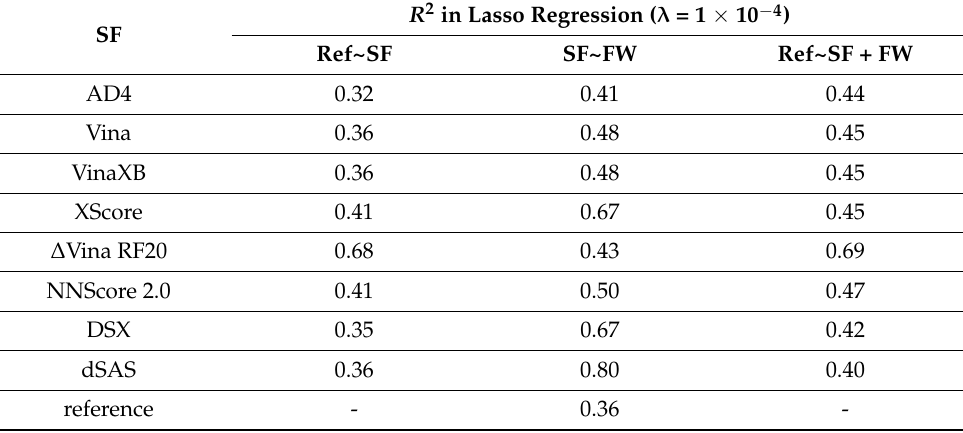
Table 9. Determination coefficient ( R 2 ) for different